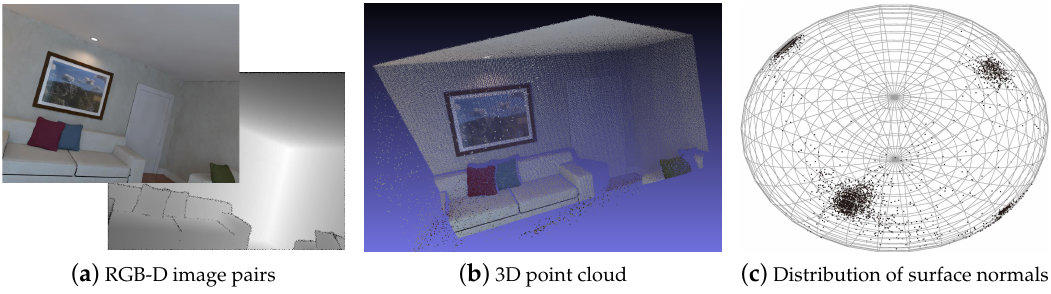
Figure 1. Single RGB-D frame and distribution of surface normals corresponding to its 3D point cloud. ( a ) Frame 85 in ’LivingRoom0’ sequence of ICL-NUIM dataset. ( b ) 3D point cloud obtained by back-projecting the depth information and coloring with aligned RGB pixels. ( c ) Distribution of surface normals on the unit sphere.